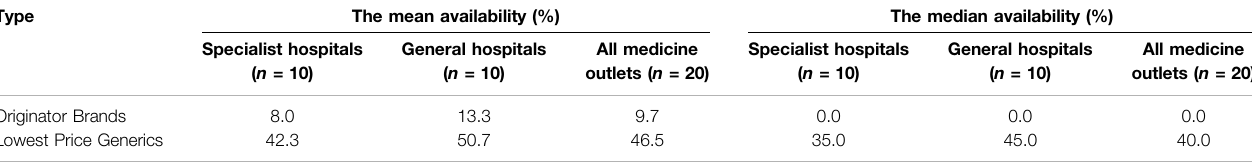
TABLE 4 | Mean and median availability of medicines for children.